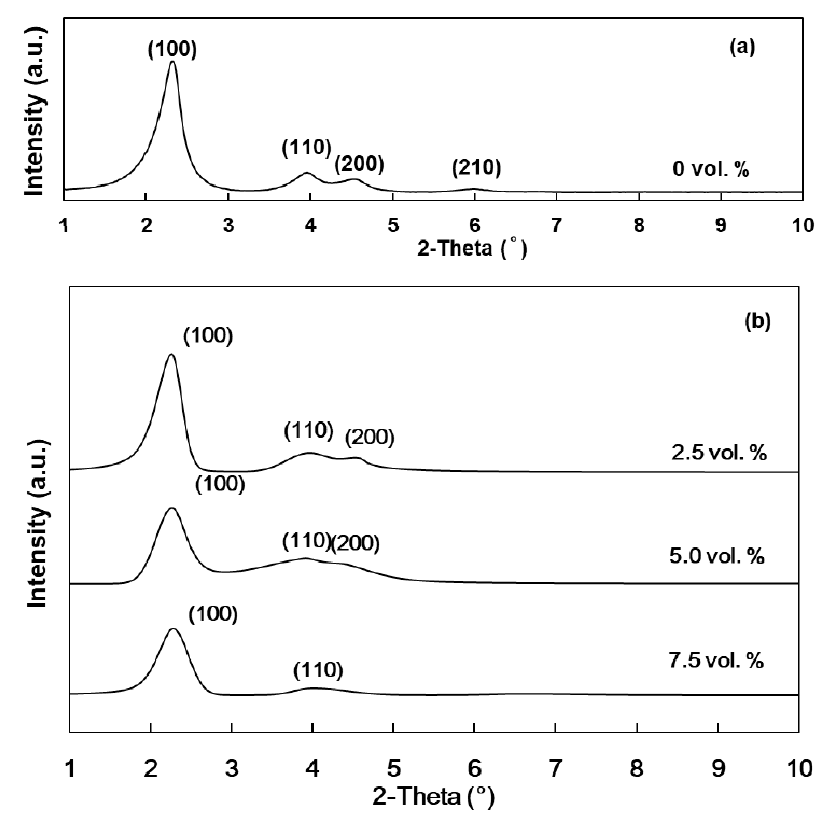
Figure 2. Small-angle XRD patterns of grafted NH 2 -Al/MCM-41 with different amine functional groups. ( a ) 0 vol %; ( b ) 2.5 vol.%–7.5 vol.%.